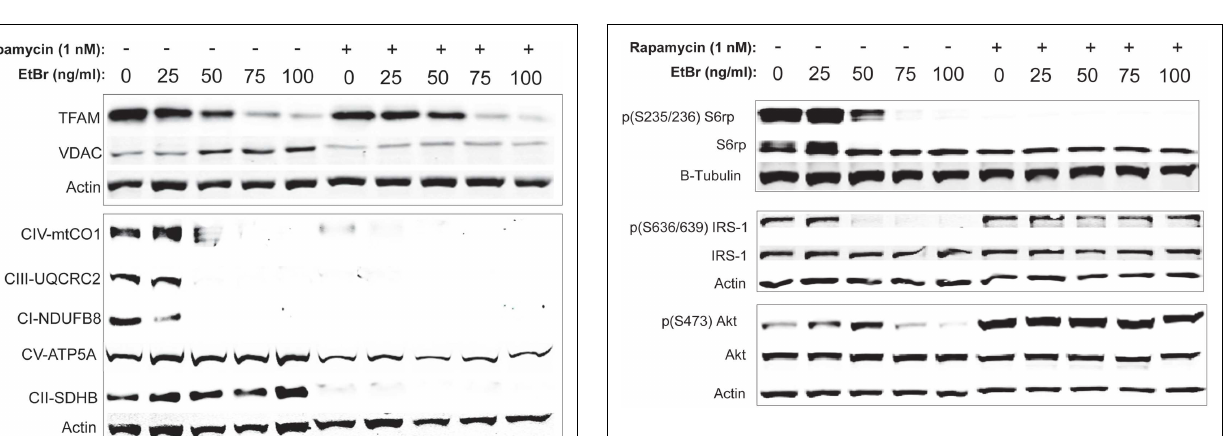
FIGURE 7 | Phosphorylation state of ribosomal S6, IRS-1, andAkt proteins following ethidium bromide exposure . Human fibroblast cell cultures grown in the presence or absence of 1nM rapamycin were exposed to increasing doses of ethidium bromide for a period of 7days. At this time, total cellular protein extracts were prepared and analyzed by immunoblot as described in Section “Materials and Methods” for a subset of mitochondrial resident proteins.The levels of beta-actin are presented as a control for equal protein loading.The immunoblot presented is a representative blot of a minimum of two measurements with similar